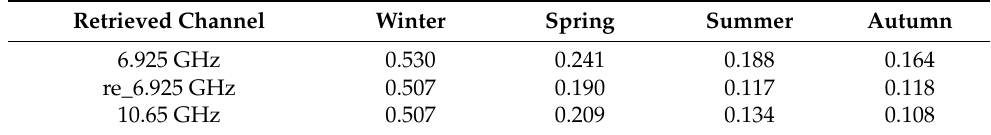
Table 1. Missing rate of soil moisture retrieval from the different